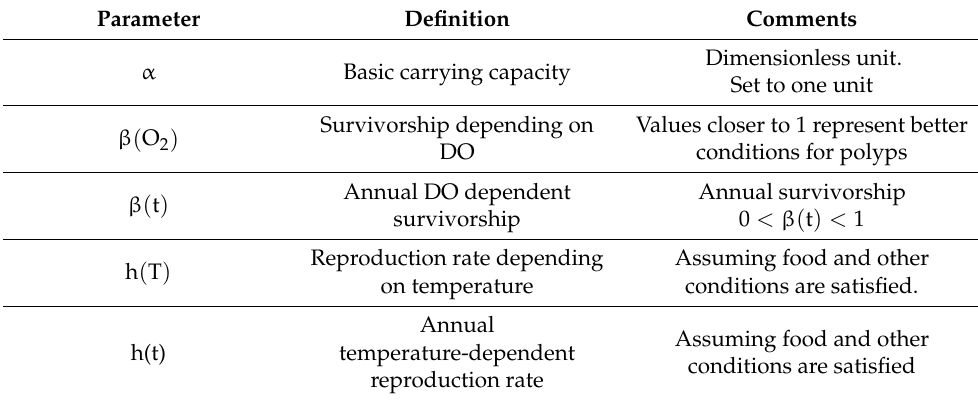
Table 1. Summary of the parameters used in the construction of a model of the population dynamics of Aurelia coerulea